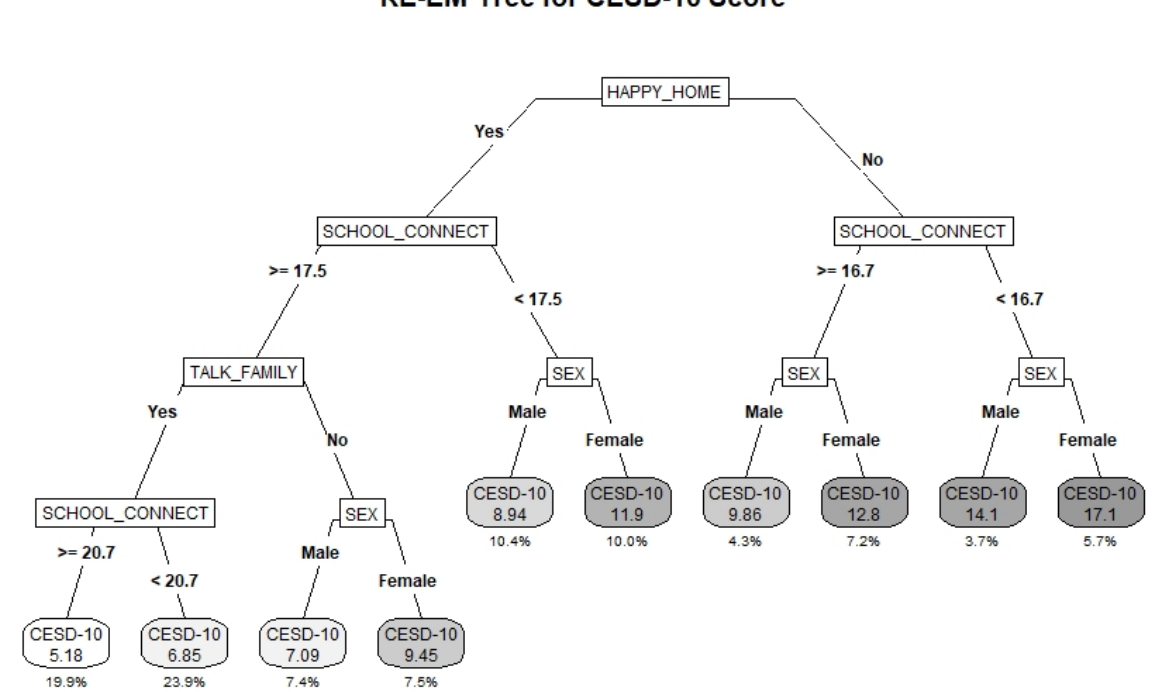
Figure 2. RE-EM Tree predicting average CESD-10 score for students participating in Year 7 (2018– 2019) of the COMPASS Study ( N = 70,610). The CESD-10 score represents the average scale score within the subgroup. The percentage below represents the total percentage of the sample comprised by the subgroup.